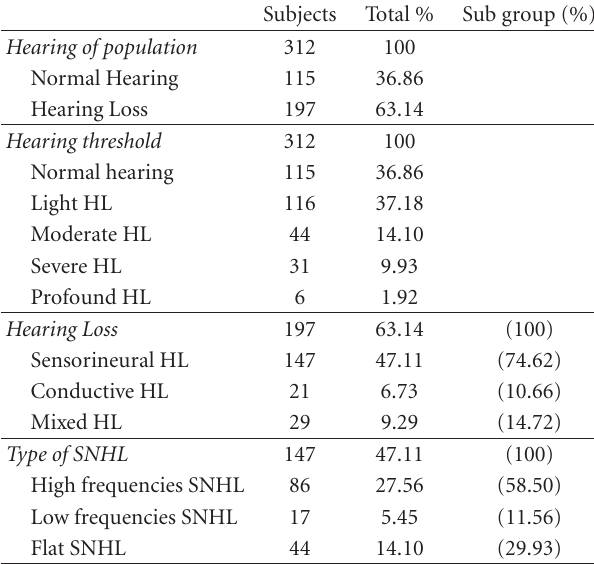
Table 2: Tinnitus participants: Audiological characteristics.